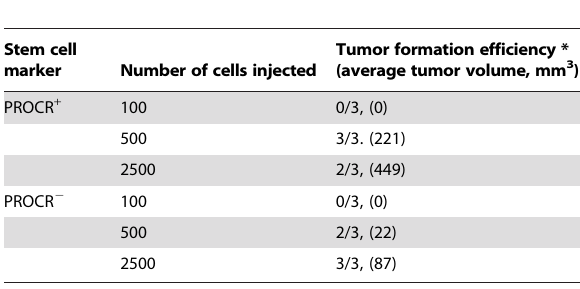
Table 3. Xenograph and tumor growth in NOD/SCID injected with PROCR + or PROCR 2 MDA-MB-361